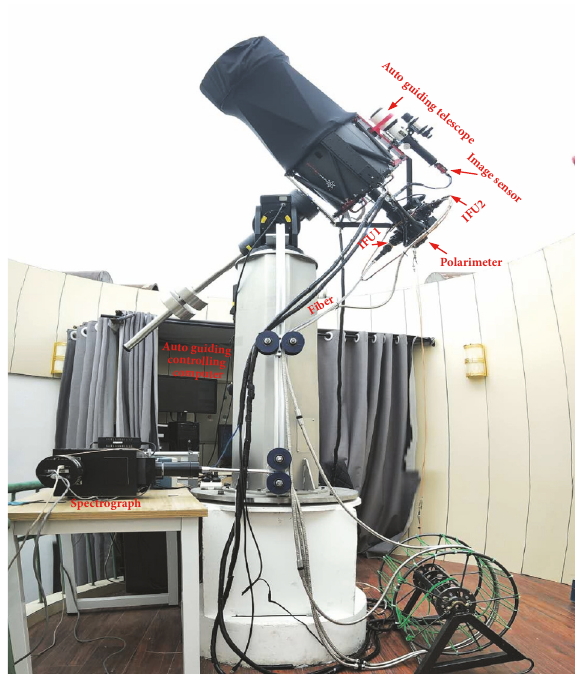
Figure 7: The physical map of